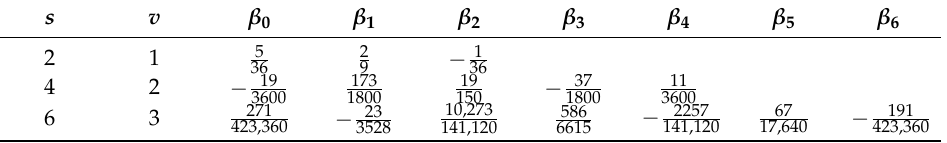
Table 4. Coefficients of generalized Adams methods (GAMs) using uniform grids (for even s ).